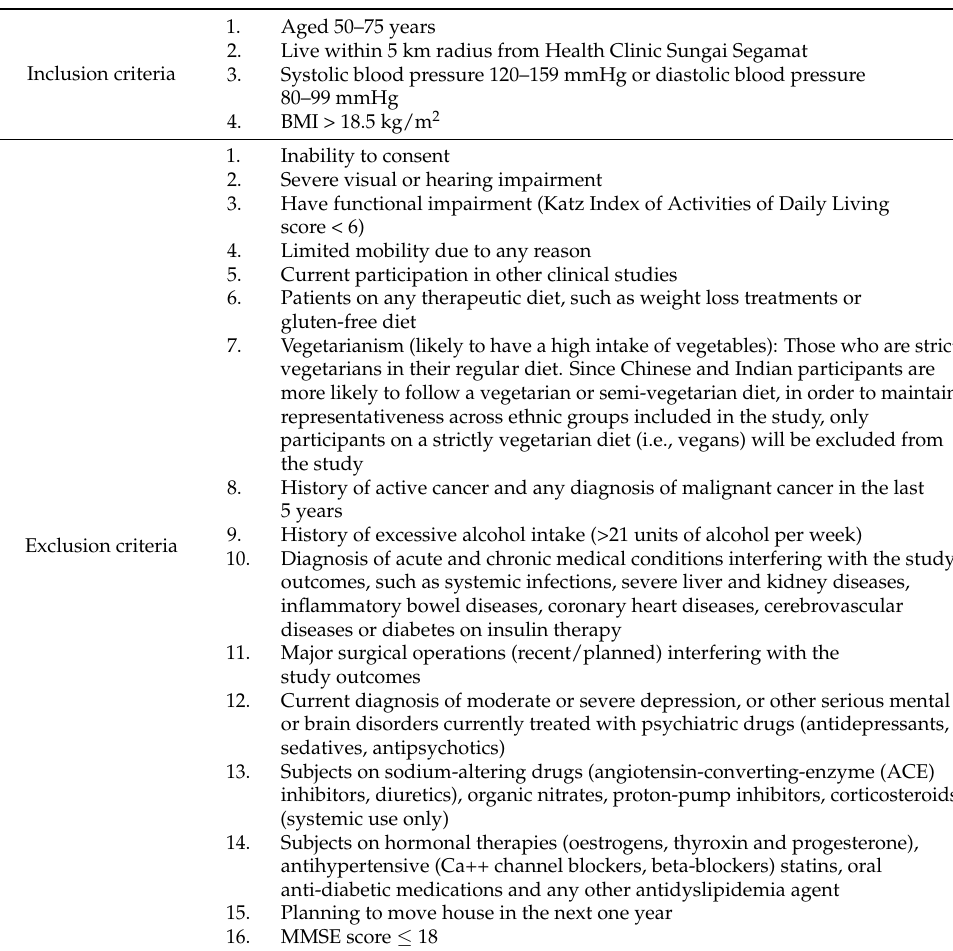
Table A1. Eligibility criteria for trial participants.